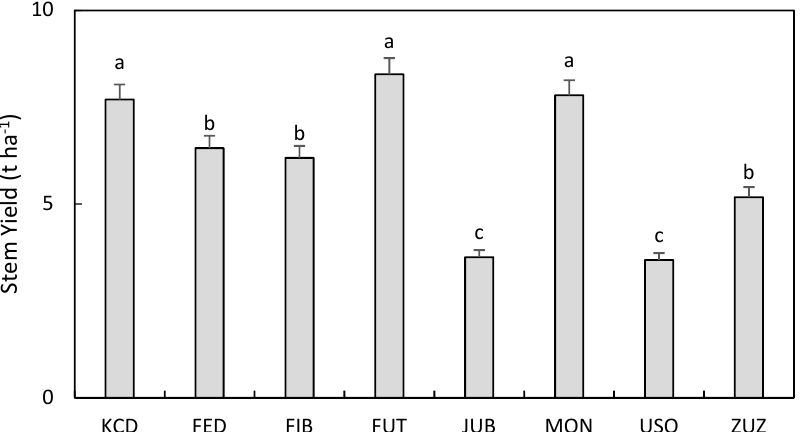
Figure 6. Stem yield at seed harvest of the hemp cultivars studied (KCD = KC Dora; FED = Fedora 17; FIB = Fibrol; FUT = Futura 75; JUB = Jubileu; MON = Monoica; USO = Uso-31; ZUZ = Zuzana). Means followed by the same letter are not significantly different (SNK at the 5% level). Error bars are standard deviations.